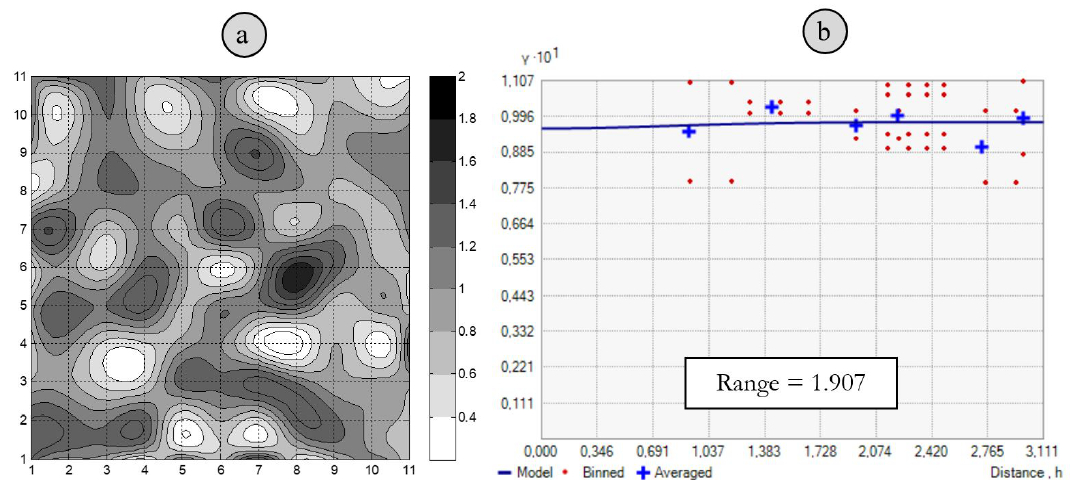
Figure 5. a) Spatial distribution of the numerical simulation with Lcor = 1, b) Semivariogram obtained with ArcGis analysis of the numerical simulation with Lcor = 1.